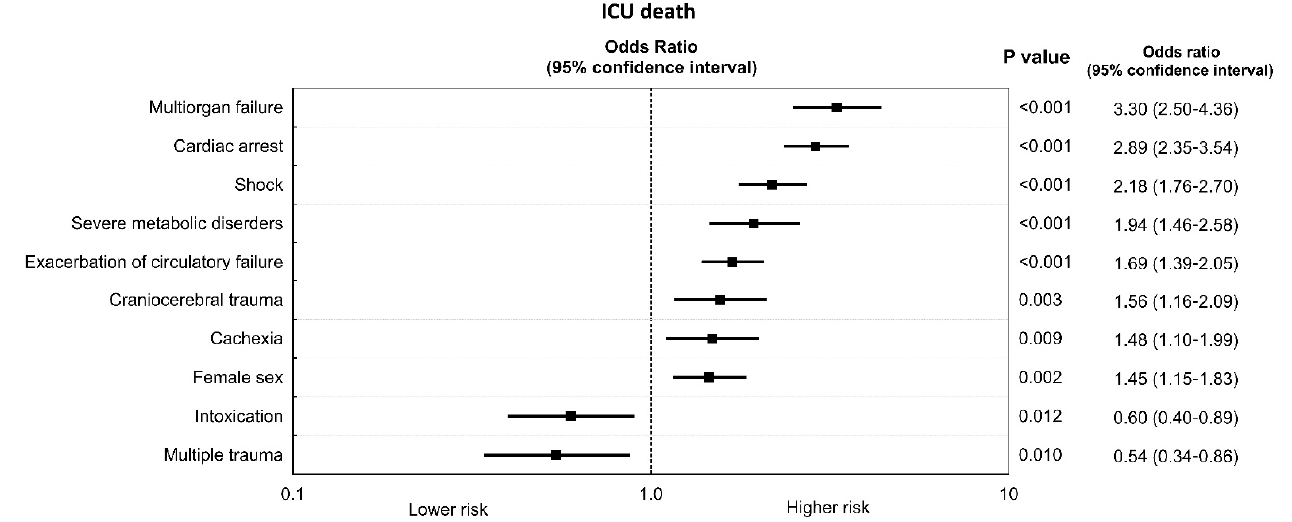
Figure 4. Independent predictors of ICU death in patients with AD.